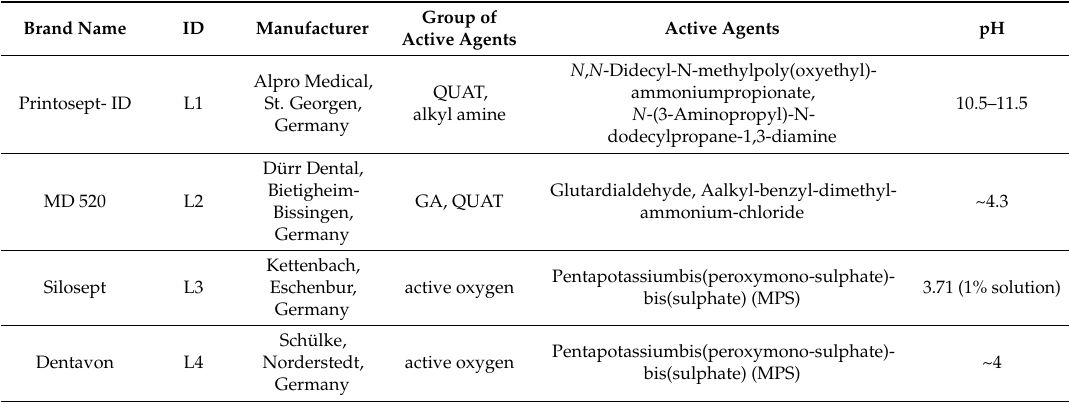
Table 1. Information about tested chemical disinfectants.